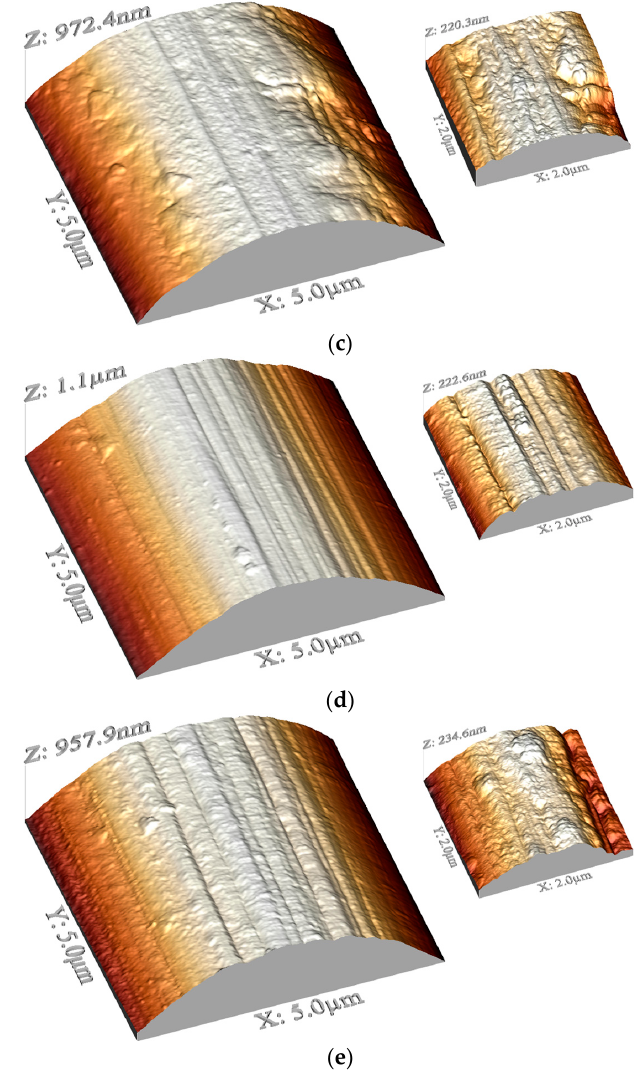
Figure 3. AFM images of uncoated and coated carbon fibers in 3D mode: carbon fibers without coating ( a ); and carbon fibers modified with coating 1 ( b ); coating 2 ( c ); coating 3 ( d ); and coating 4 ( e ).